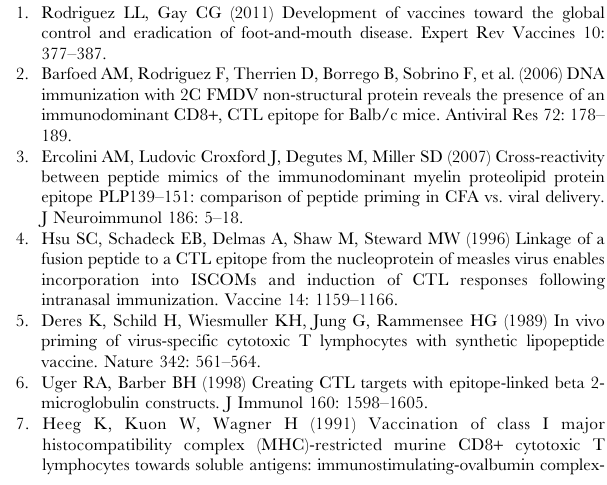
Group Animal numbers Numbers of animals with score of histological of cellular lesions (hepatic